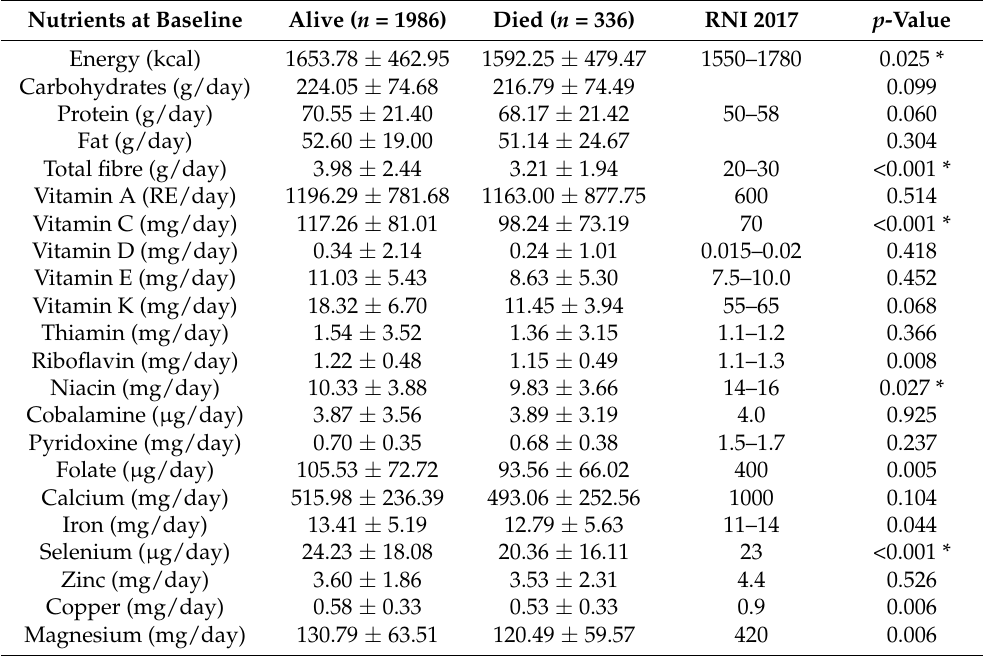
Table 5. The baseline dietary nutrient intake of respondents who were alive and those who died after 5 years [presented as mean ± standard deviation (sd)].